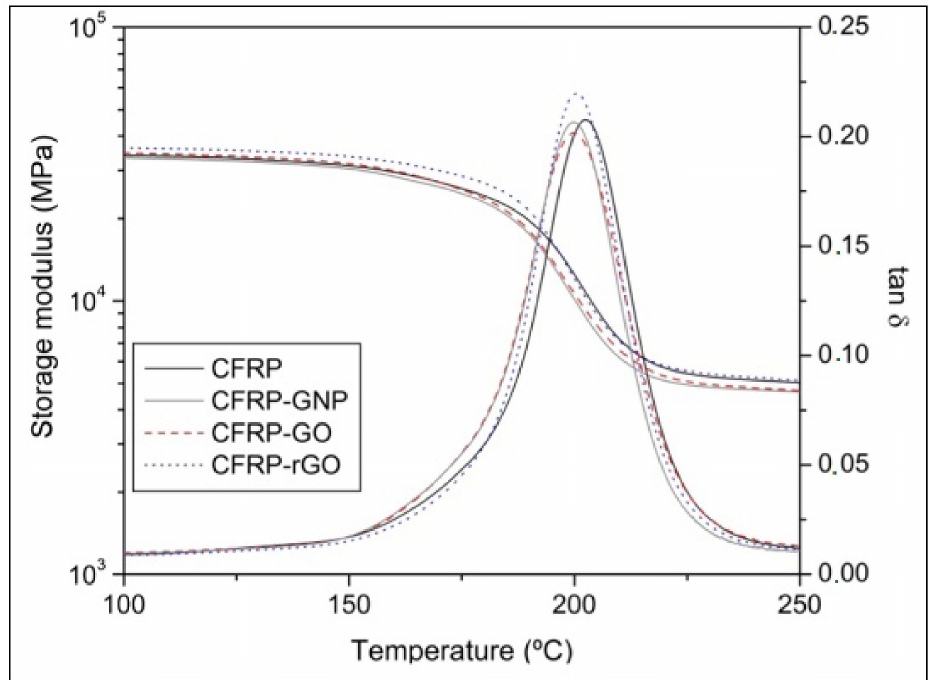
Figure 12. Storage modulus and tan δ curve for different nanoparticles